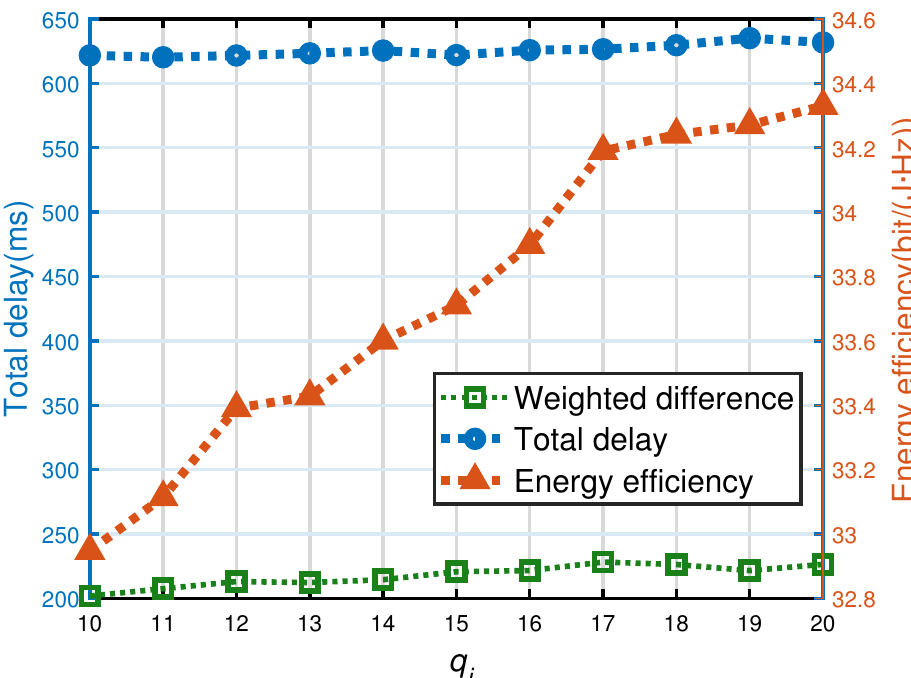
Figure 5. Total delay, energy efficiency, and weighted difference versus q j